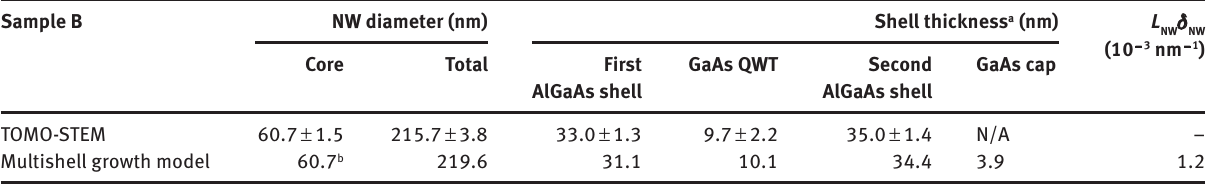
Table 1: Comparison between GaAs and AlGaAs shell thickness values, as measured from analysis of HAADF-STEM tomography of the GaAs- AlGaAs core-multishell nanowire in Figure 4, and simulated ones based on the multishell growth model [22, 23]. Sample B